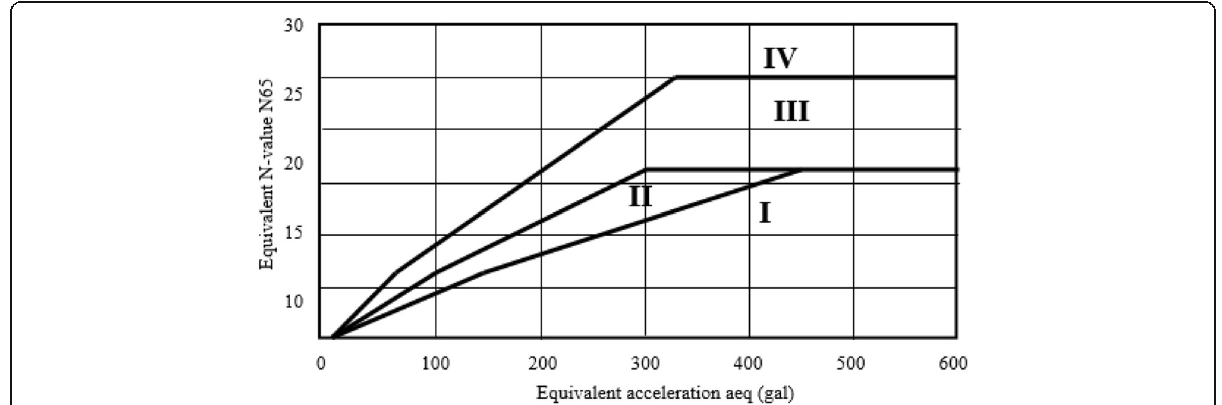
Fig. 2 Classification of soil layer with equivalent N-value and equivalent